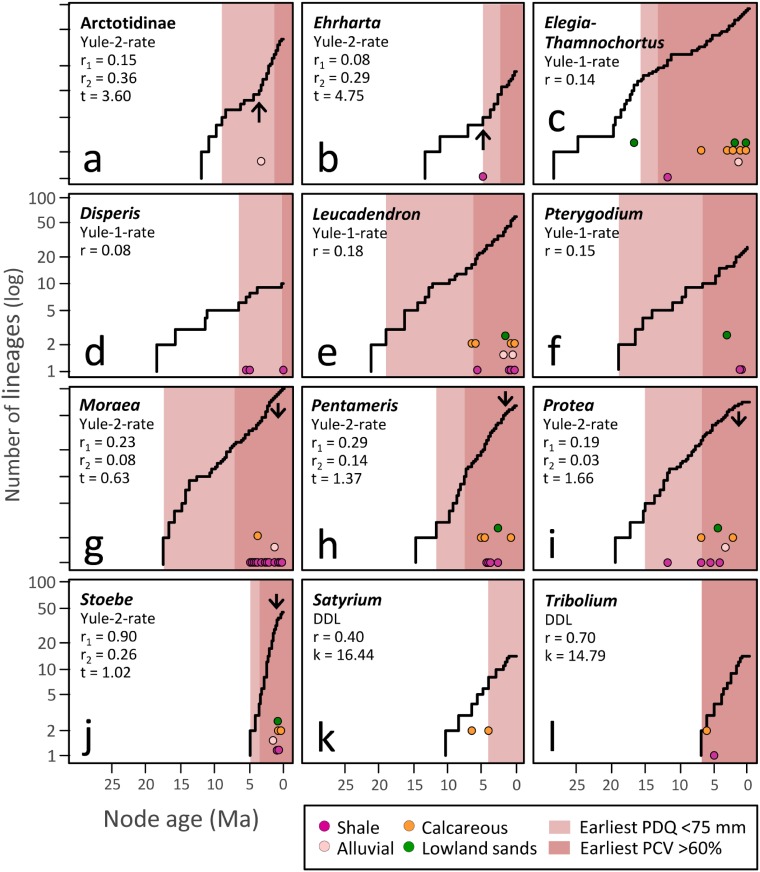
Lineage-through-time plots and best-fit diversification rate models for the 12 CFR clades.Log-lineage-through-time plots for the 12 clades, with the best-fit models of diversification and associated parameter estimates shown. Where the best-fit model invoked two rates, arrows are used to indicate the timing of the rate shift, upward and downward arrows indicating accelerations and decelerations, respectively. For each clade, initial shifts to environments characterized by PDQ <75 mm and PCV >60% are indicated by pale and dark shading, respectively. Shifts to non-quartzitic substrata are indicated by colour-filled circles.